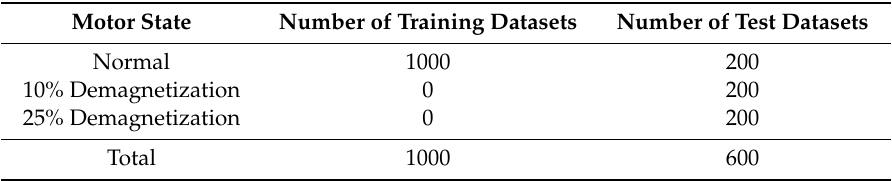
Table 2. Classification of data collection.